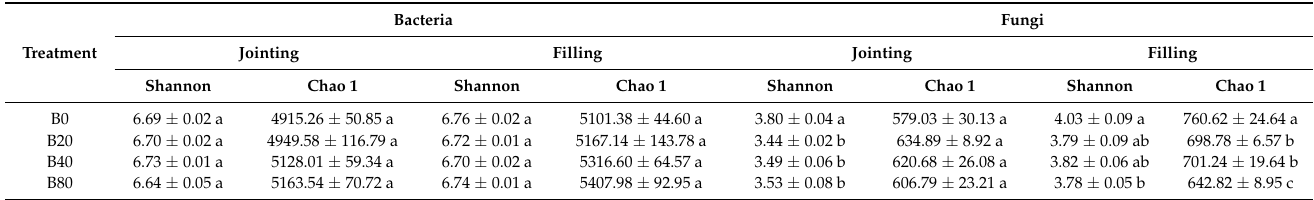
Table 3. Effects of biochar on bacteria and fungi alpha diversity